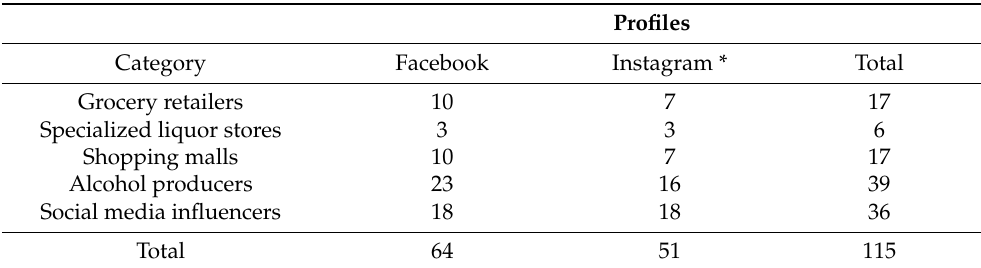
Table 2. Summary of monitored Facebook and Instagram profiles by category.